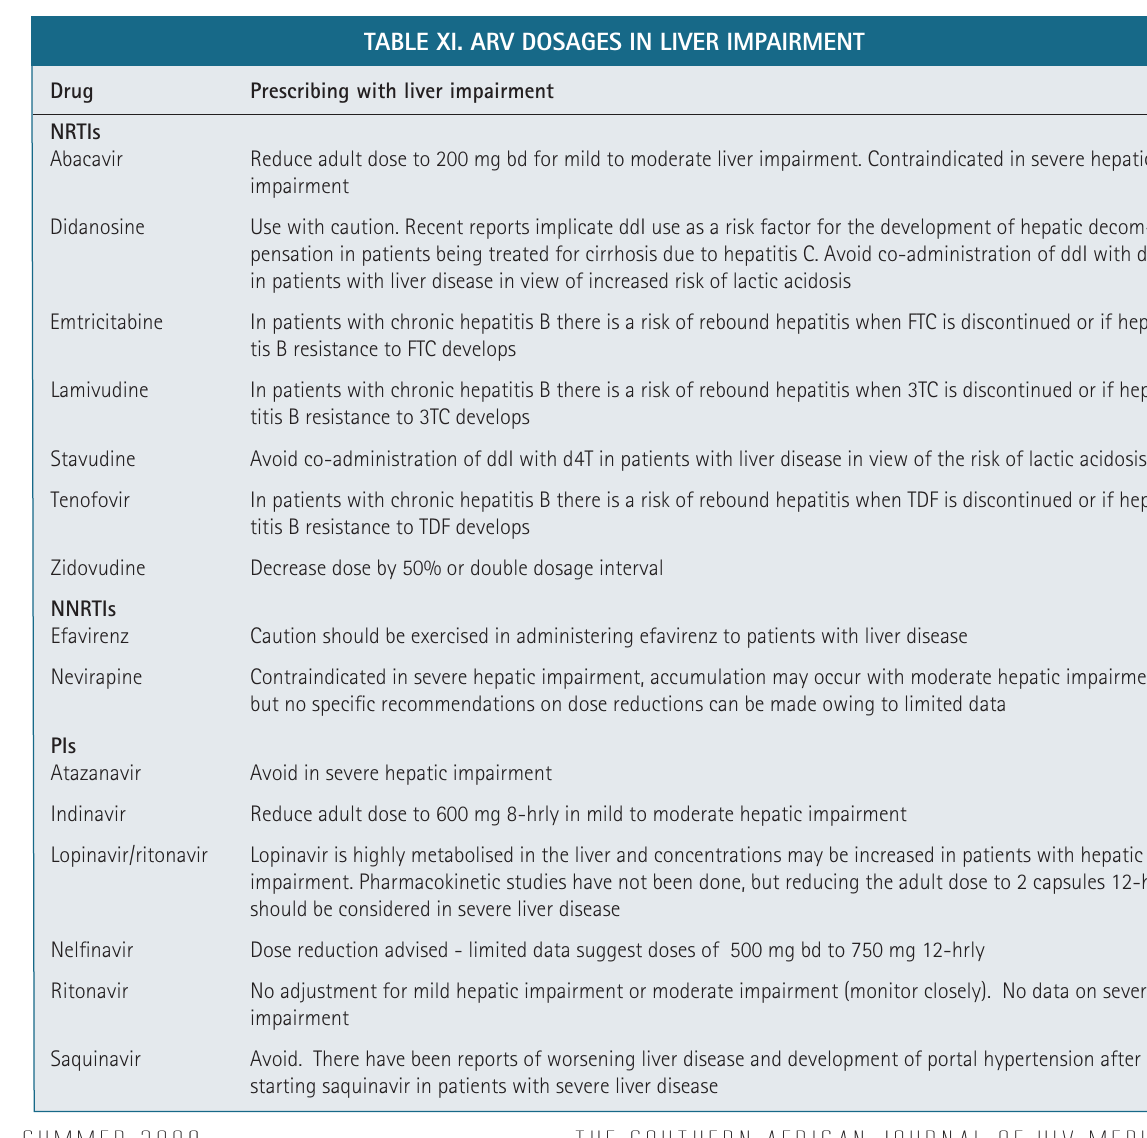
tAble Xi. ARV dosAGes iN liVeR iMPAiRMeNt